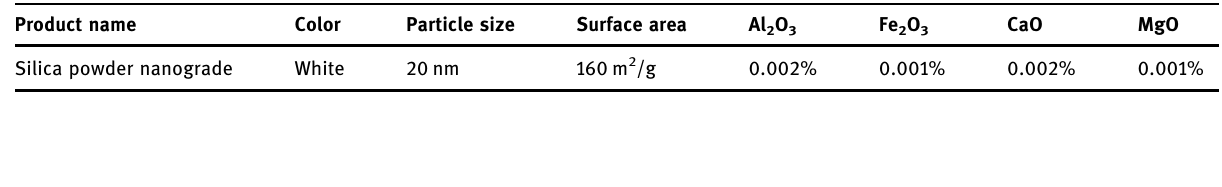
Table 3: Properties of superplasticizer ( EUCOBET SUPER VZ ) according data sheet